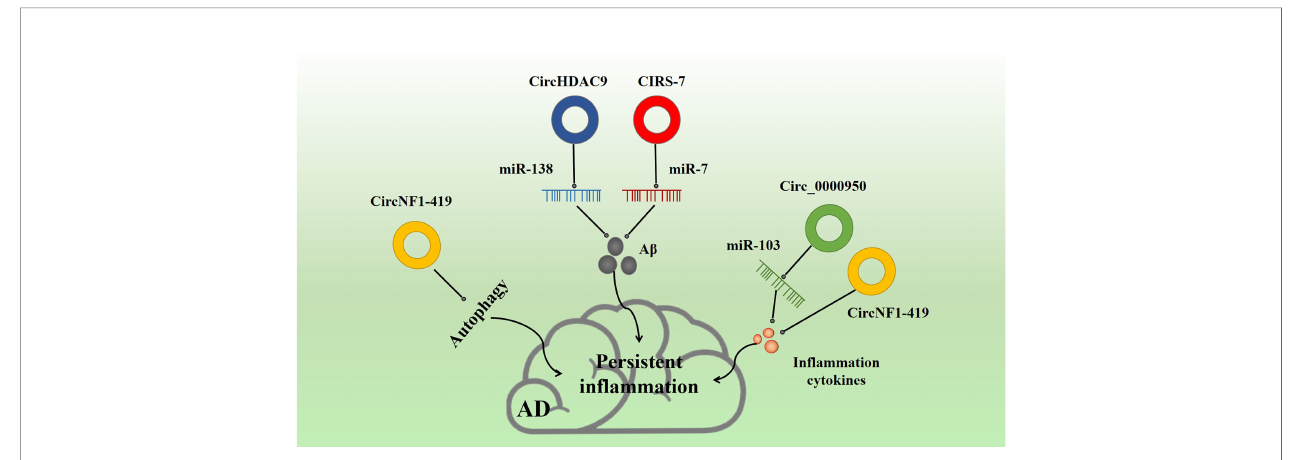
FIGURE 5 | Effect of in fl ammatory circRNA on AD in fl ammation. Multiple in fl ammatory circRNAs participate in various in fl ammation-related pathways. For example, CIRS-7 and NF1-419 promote A b -induced in fl ammation. circ_0000950 and circNF1-419 are associated with the release of in fl ammation cytokines, and circNF1-419 is associated with